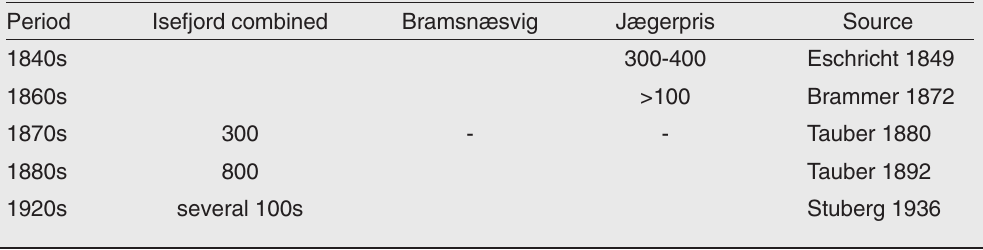
Table 1. Earlier published catch reports from the Isefjord